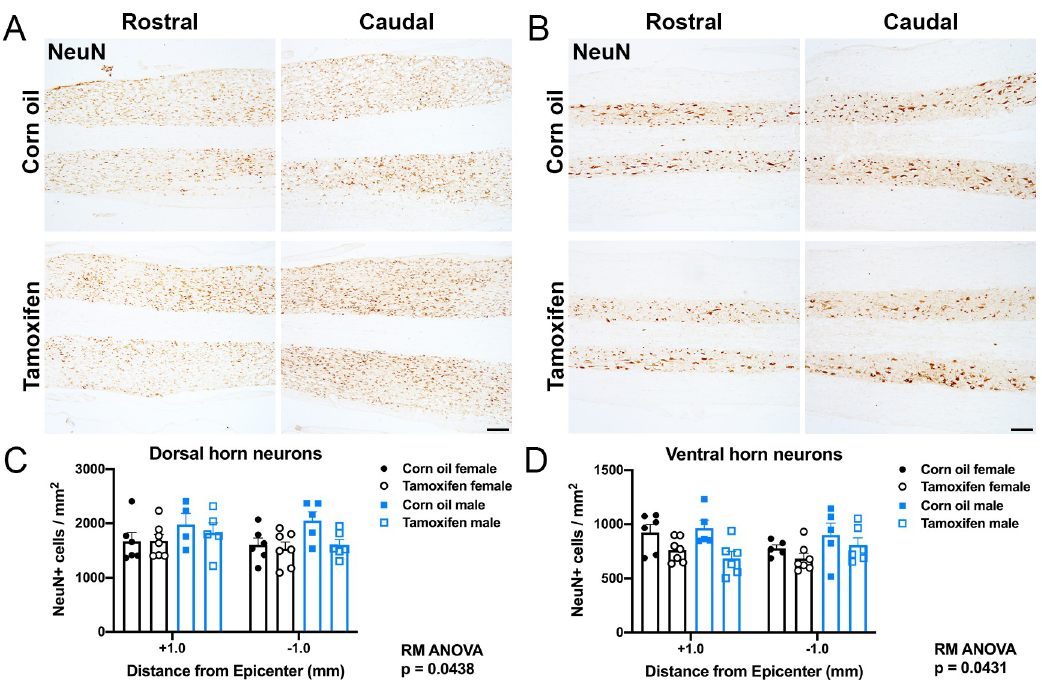
Fig 4. Neuronal survival after SCI does not change with delayed tamoxifen treatment. (A-B) Representative images of NeuN labeling in the gray matter of the (A) dorsal horn and (B) ventral horn 1 mm rostral and caudal to the lesion epicenter after corn oil or tamoxifen gavage. Scale bar = 100 μ m. (C-D) Tamoxifen mice had significantly fewer NeuN+ cells in the (C) dorsal horn (p = 0.0438) and the (D) ventral horn overall compared to control mice (p = 0.0431). Sex did not impact neuron number in the dorsal or ventral horn. Data presented as mean + SEM. Mixed-effects analysis with Sˇı´da´k post hoc test; corn oil female n = 6; tamoxifen female n = 7; corn oil male n = 5; tamoxifen male n = 6.